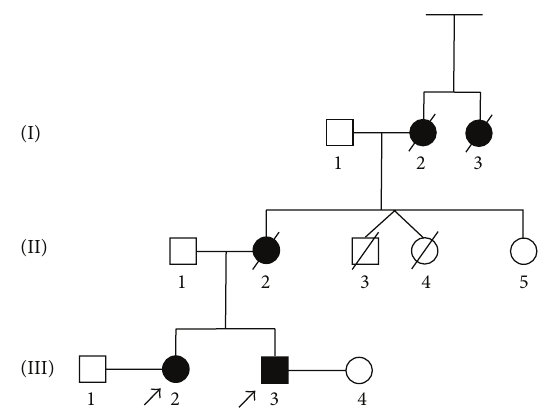
Figure 1: Pedigree of the family of siblings with Parkinson’s disease (PD). Black boxes represent affected